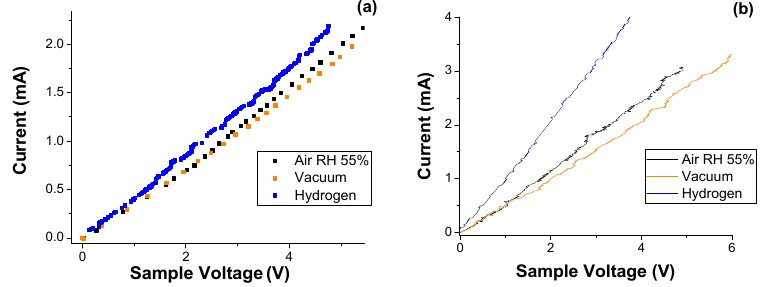
Figure 3. Electrical current as function of the applied voltage of ( a ) untreated and ( b ) treated ICPM composite at room temperature.